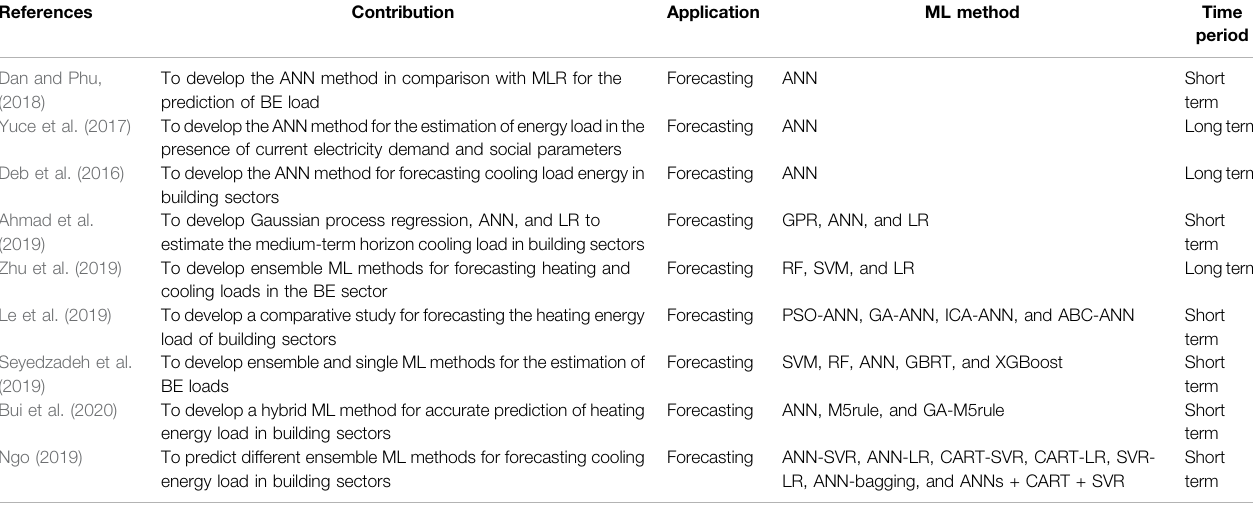
TABLE 6 | Studies developed for forecasting energy load in the building